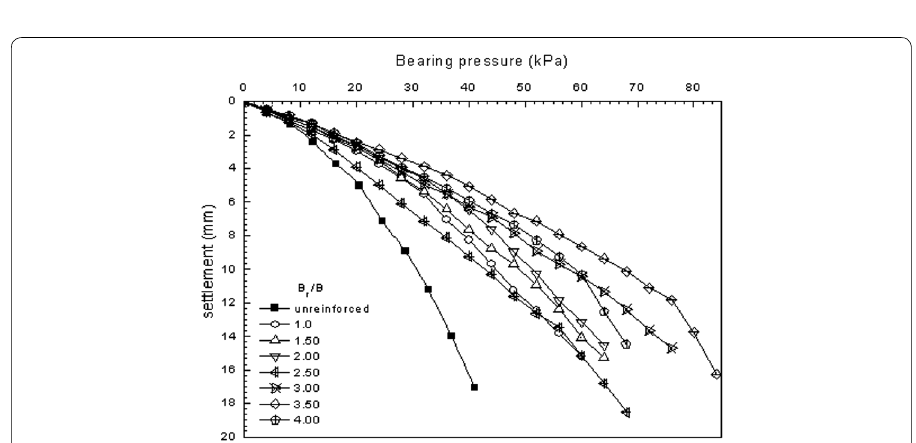
Fig. 9 Bearing pressure-settlement behavior of 75 mm square model footing on geojute reinforced sand (reinforcement depth ‘D r ’ =